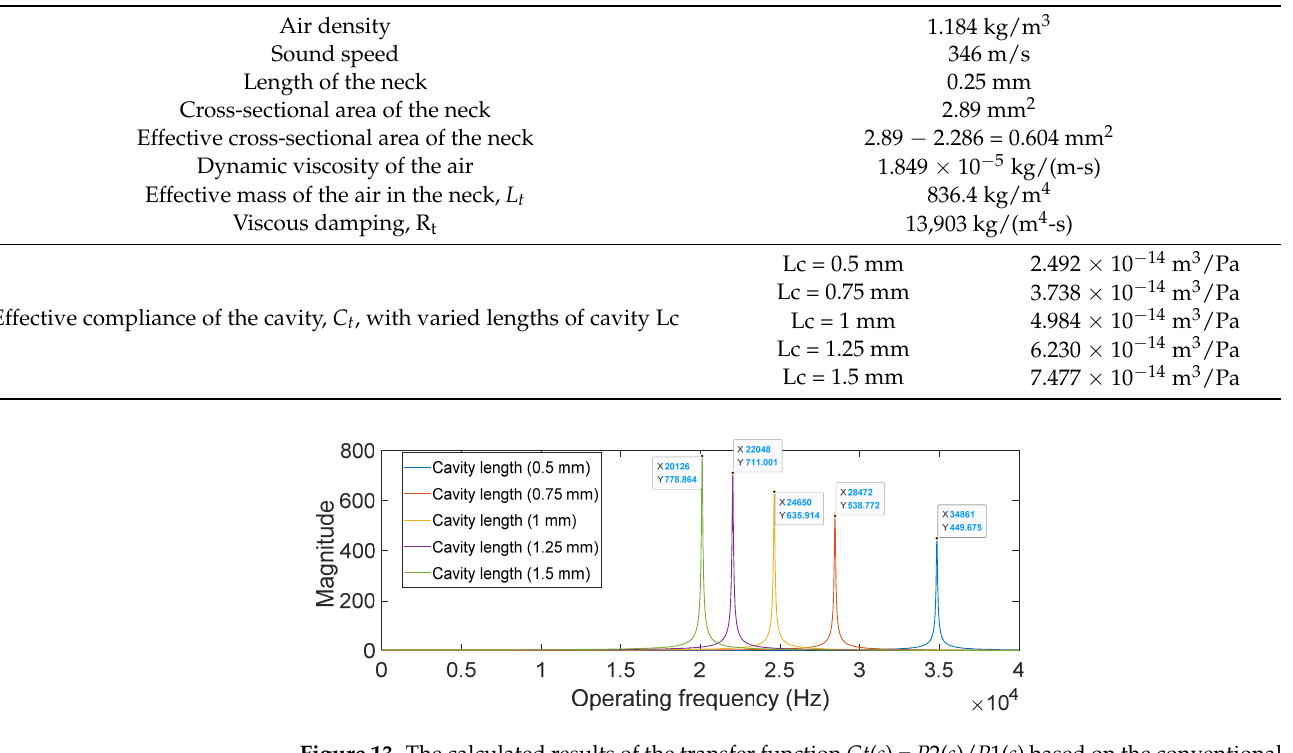
Table 2. The physical parameters used in the conventional Helmholtz resonator model for the studied cases.